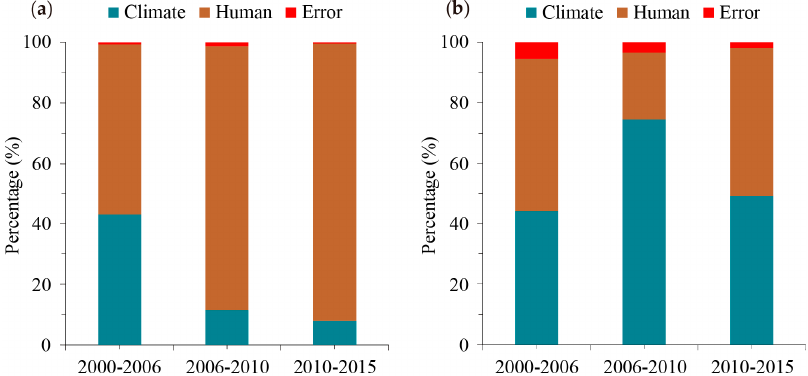
Figure 7. Contributions of climate change and human activities in various periods for ( a ) desertification reversion and ( b ) expansion.